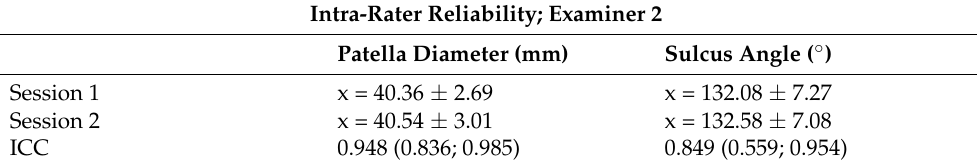
Table 3. Results of the patella diameter and sulcus angle measured in the right knee by the inexperi- enced examiner during the first and second measurement sessions. The intra-rater reliability for the inexperienced examiner.